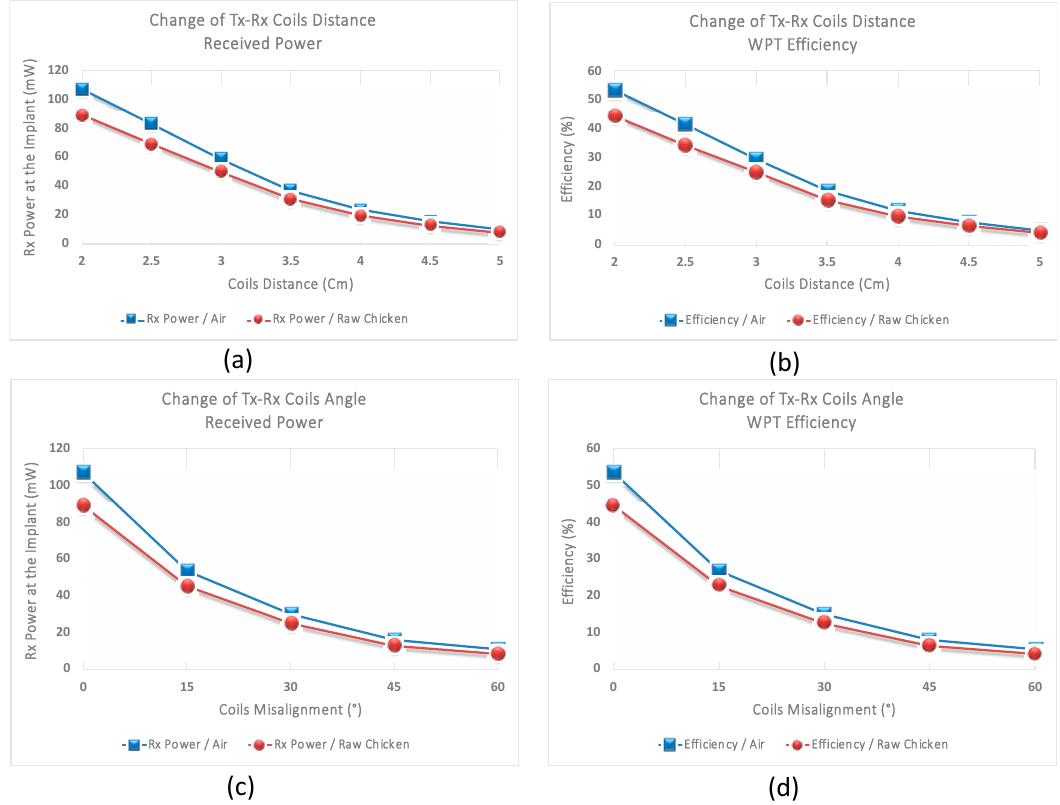
Figure 8. ( a ) and ( b ) show the received power and efficiency when the distance between the TX and RX coils is changed from 2 cm to 5 cm for air and raw chicken. ( c ) and ( d ) show the received power and efficiency when the alignment between the TX and RX coils is changed from 0° to 60° for air and raw chicken.